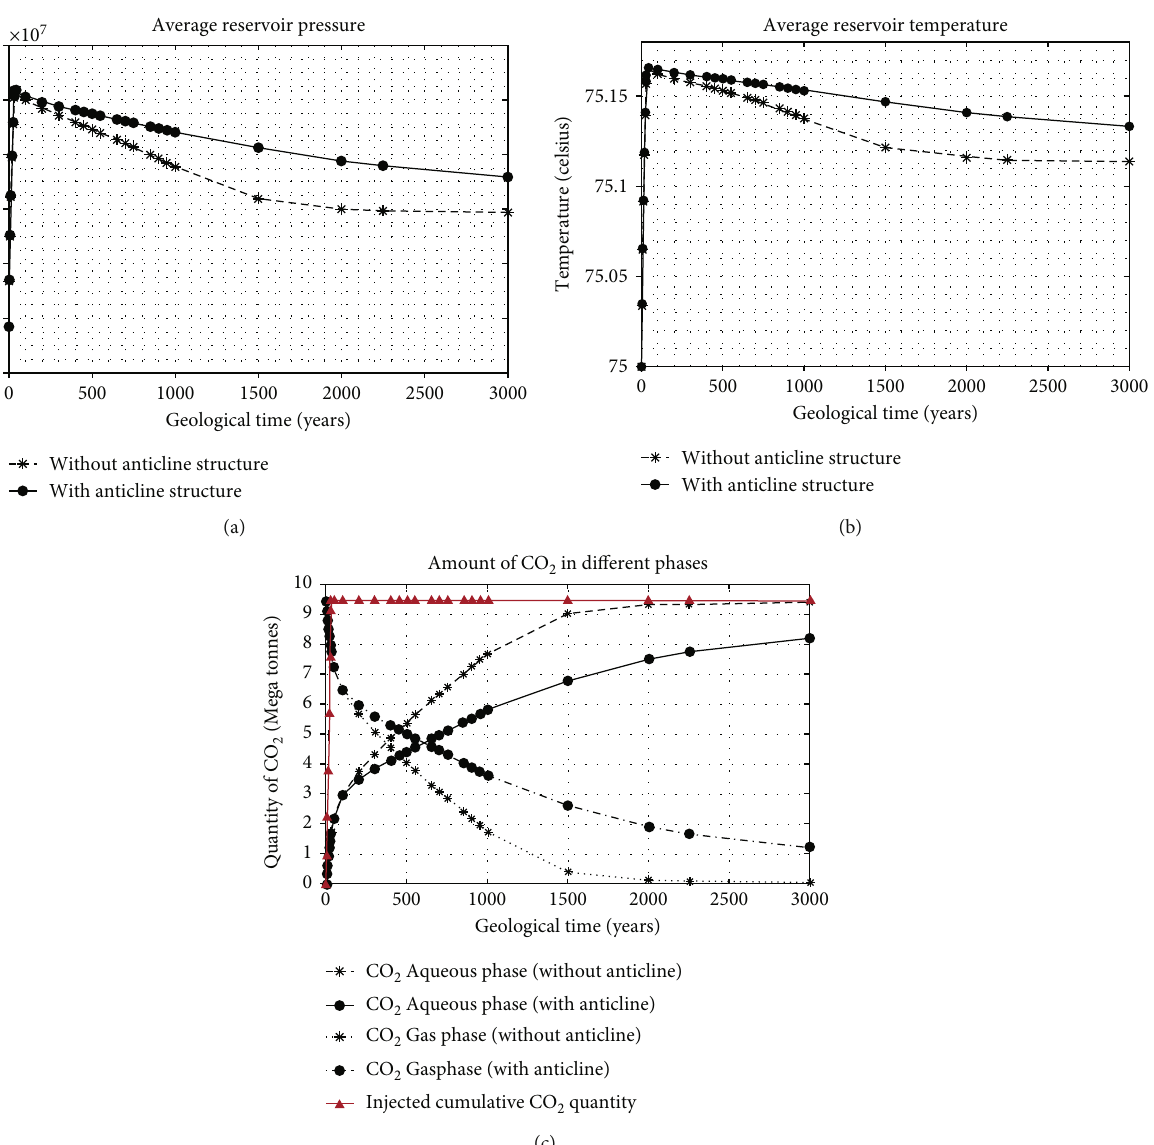
Figure 7: In fl uence of caprock morphology on (a) average reservoir pressure, (b) average reservoir temperature, and (c) aqueous and gaseous phase CO quantity variation over geological time 2